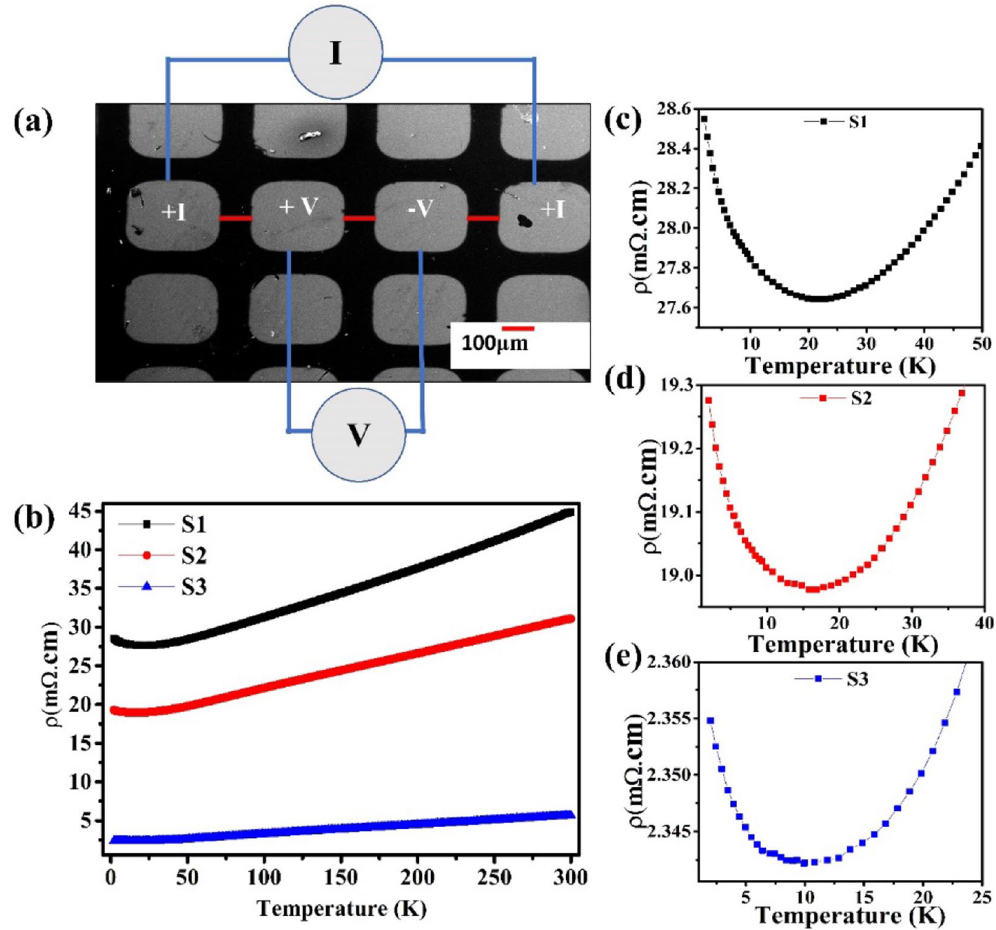
Figure 5. ( a ) SEM image of the fabricated device for low temperature transport measurements and ( b ) temperature dependent (2–300 K) resistivity curves for S1–S3 samples. ( c – e ) Represent the resistivity data at narrow temperature range of 2–50 K for S1, S2 and S3 samples,